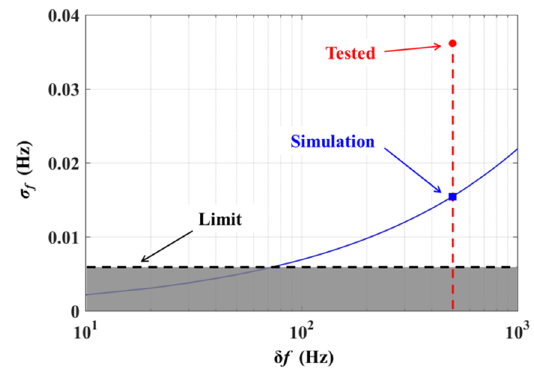
Figure 9. Frequency noise of beat signals as a function of the initial beat linewidth.